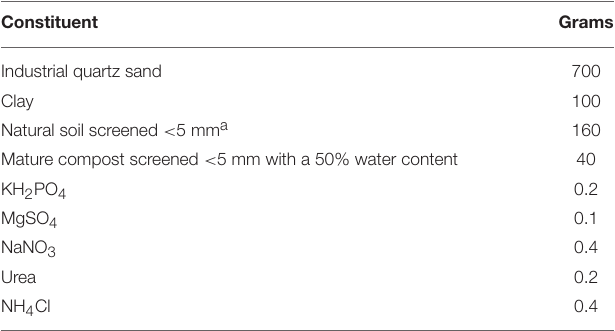
TABLE 5 | Preparation of one Kg (dry) of standard